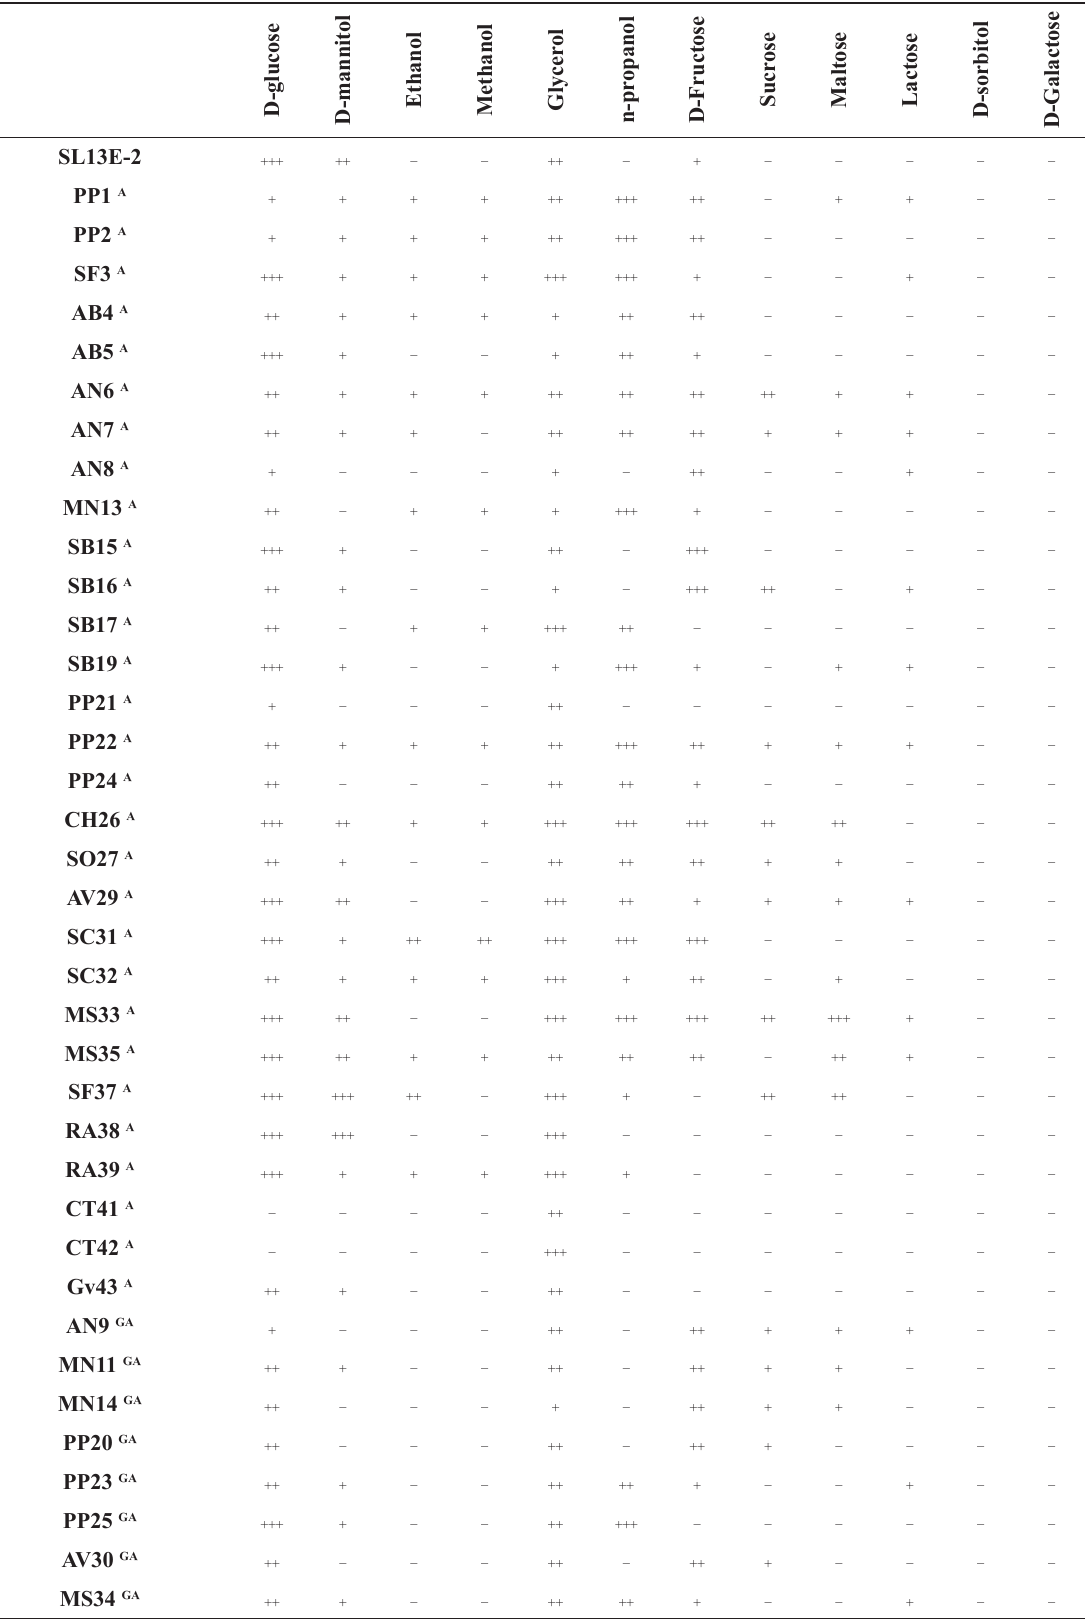
Table 2: Carbon source utilization pattern of isolated Acetobacter , and Gluconacetobacter